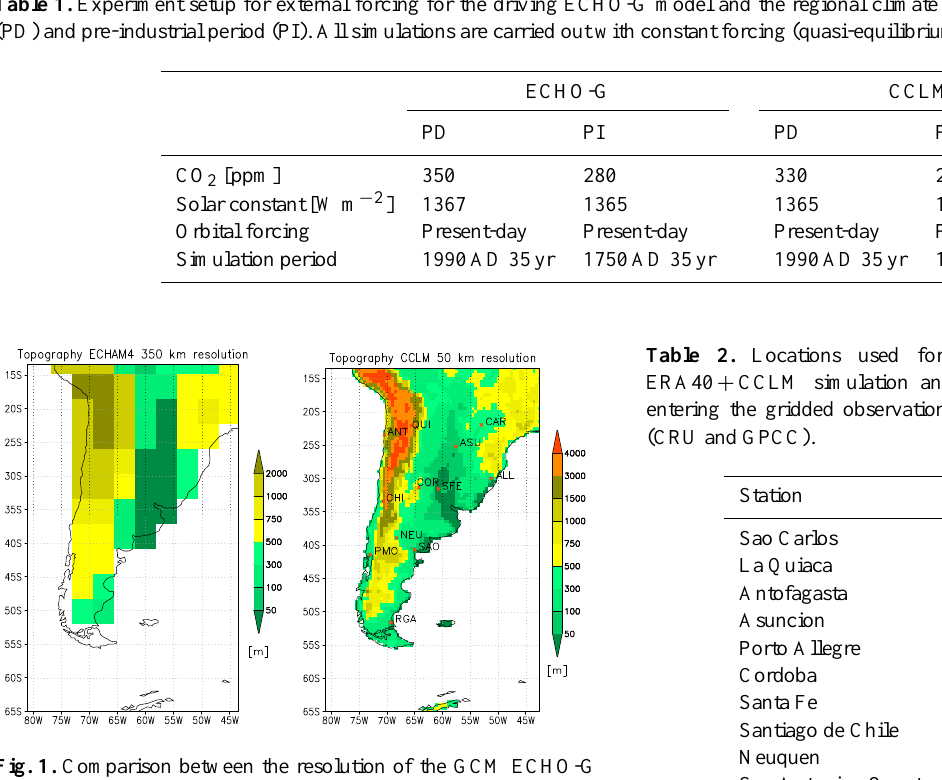
Fig. 1. Comparison between the resolution of the GCM ECHO-G (350km) and CCLM (50km). Note the considerable increased res- Figure 1 : Comparison between the resolution of the GCM ECHO-G (350 km) and CCLM (50 olution of the regional climate model, most notably for the Andes Mountains. The grid points used for comparison are indicated in km). Note the considerable increased resolution of the regional climate model, most notably for the right figure. The exact latitude and longitude information is in- the Andes Mountains. The grid points used for comparisons are indicated in the right Figure. cluded in Table 2. The exact latitude and longitude information is included in Table 1.